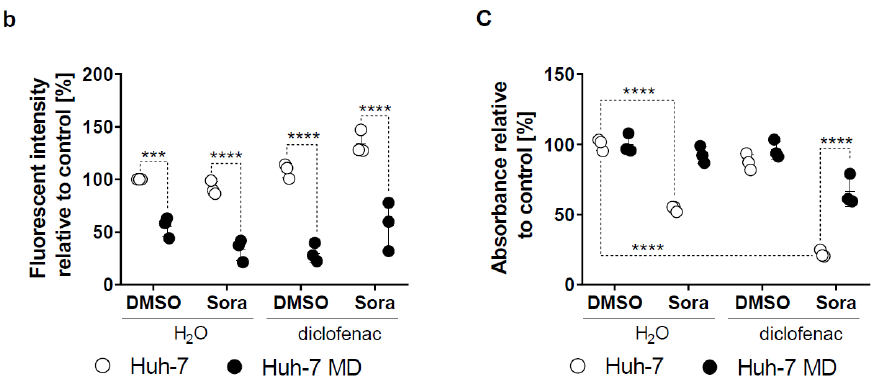
Figure 4. Sorafenib / diclofenac cotreatment increases mitochondrial ROS levels. ( a ) HCC cells were treated with sorafenib (Sora, 5 µ M) or diclofenac (100 µ M), or DMSO or H 2 O as controls, for 12 h. Mitochondrial ROS levels were quantified and expressed as mean fluorescent intensity relative to control (DMSO / H 2 O treated cells). Each point represents the mean intensity of one independent experiment run in triplicates. The mean of the control condition was set at 100%. ( b ) Huh-7 and mitochondrial DNA-deficient Huh-7 (Huh-7 MD) were treated with sorafenib (Sora, 5 µ M) or diclofenac (100 µ M), or DMSO or H 2 O as controls, for 12 h. Mitochondrial ROS levels were quantified. ( c ) MTS proliferation assay of Huh-7 and mitochondrial DNA-deficient Huh-7 (Huh-7 MD) treated for 48 h with sorafenib (Sora, 5 µ M), diclofenac (100 µ M), sorafenib and diclofenac, or DMSO or H 2 O as controls. Each dot represents the mean of a separate experiment run in triplicates. The mean of the control group (DMSO / H 2 O) was fixed at 100%. p value: * < 0.05, ** < 0.01, *** < 0.001, **** < 0.0001, ns: nonsignificant as indicated, two-way ANOVA with Sidak’s multiple comparisons test.